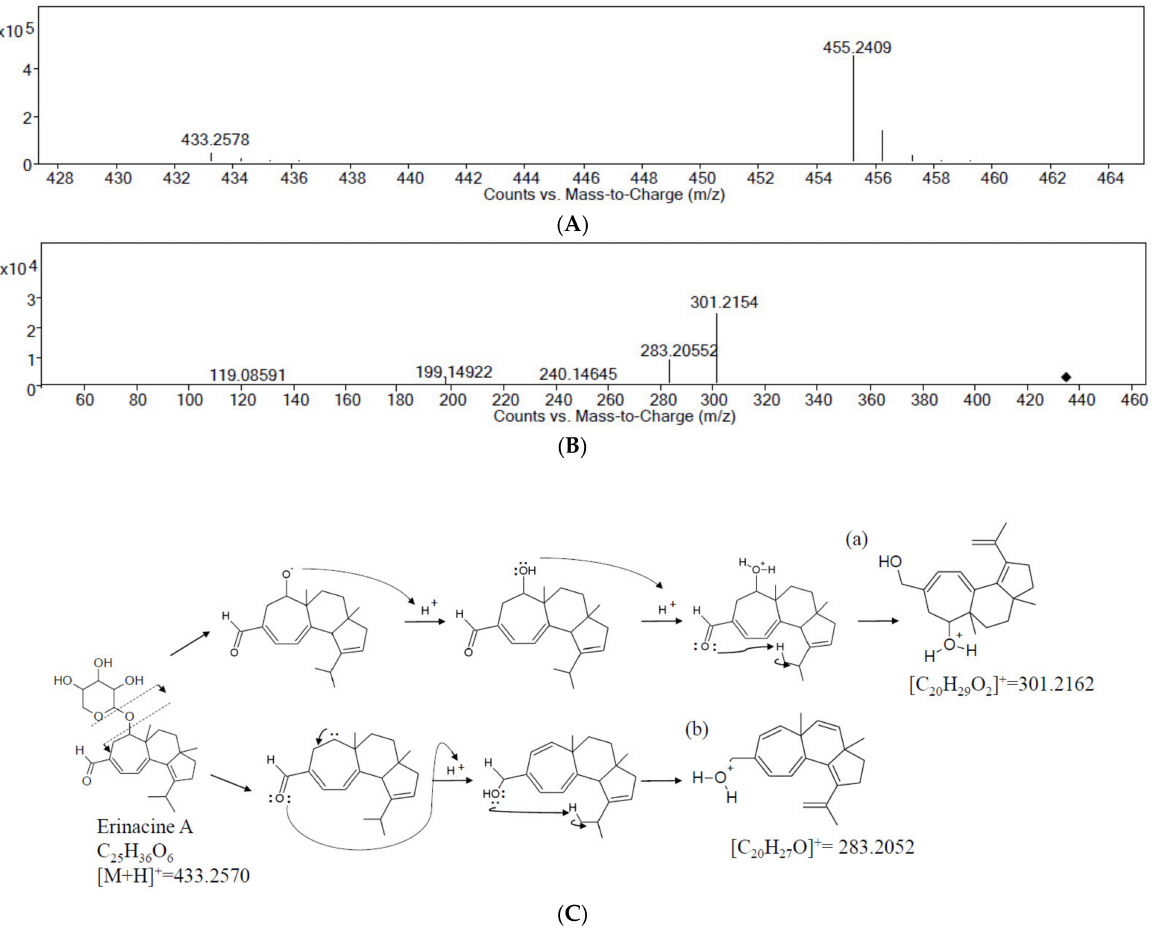
Figure 3. ( A ) MS spectrum of erinacine A with an ultra-high performance liquid chromatography tandem quadrupole time-of-flight mass spectrometry. ( B ) MS/MS spectrum of erinacine A with an ultra-high performance liquid chromatography tandem quadrupole time-of-flight mass spectrometry. ( C ) The proposed structures of product ions, produced by erinacine A, at a collision energy of 10 V.